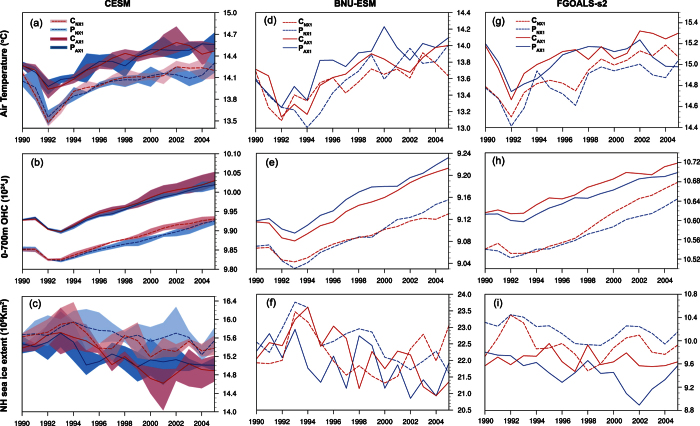
Temporal evolution of annual mean surface air temperature, upper ocean heat content (0–700 m) and Northern Hemisphere sea ice fraction simulated by CESM (left panel), BNU-ESM (middle panel), and FGOALS-s2 (right panel) under the PAX1, PNX1, CAX1 and CNX1 scenarios.Left panel: shading shows the range of values due to different initial conditions and lines are the ensemble mean.